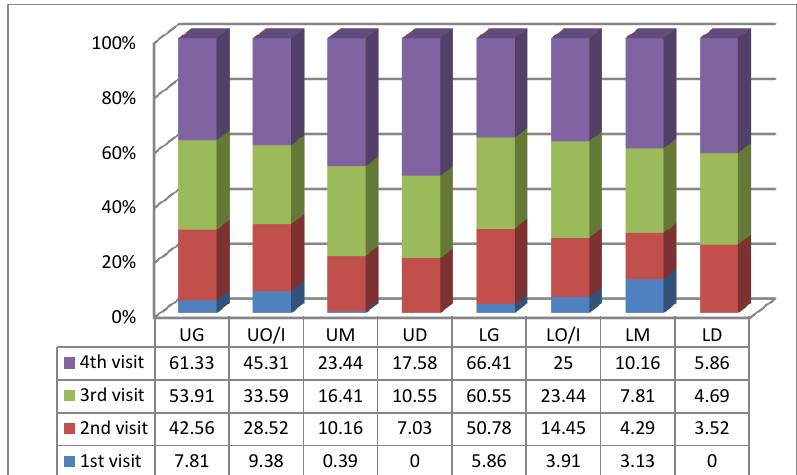
Figure 3: Distribution of white spot lesions around the brackets in maxillary and mandibular arches during four time intervals [UG= gingival area in upper teeth, UO/I= occlusal or incisal area in upper teeth, UM= mesial area in upper teeth, UD= dostal area in upper teeth, LG= gingival area in lower teeth, LO/I= occlusal or incisal area in lower teeth, LM= mesial area in lower teeth, LD= distal area in lower